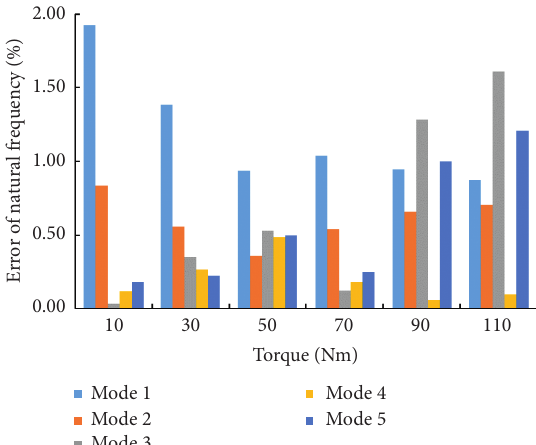
Figure 13: Updated modal damping versus preload using 1mm thin-layer element.